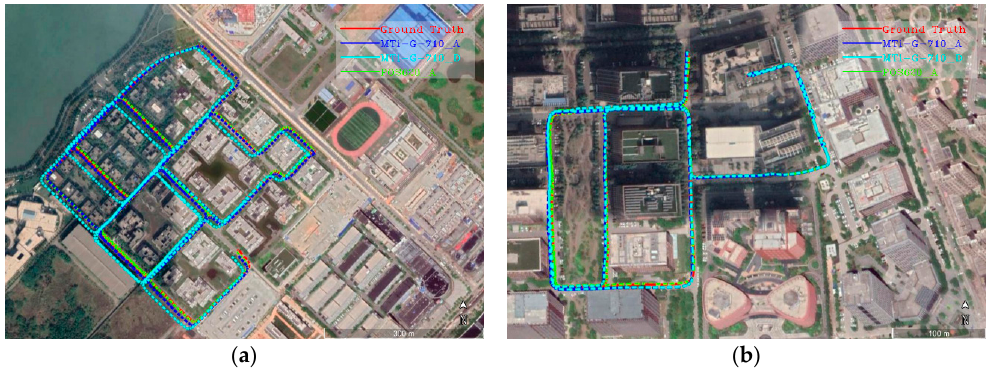
Figure 6. The trajectories with two-degree geodetic displacement of MTI-G-710 under Setting A and Setting D, and POS620 under Setting A: ( a ) The trajectories for the sequence WRIC, and ( b ) the trajectories for the sequence GFH.